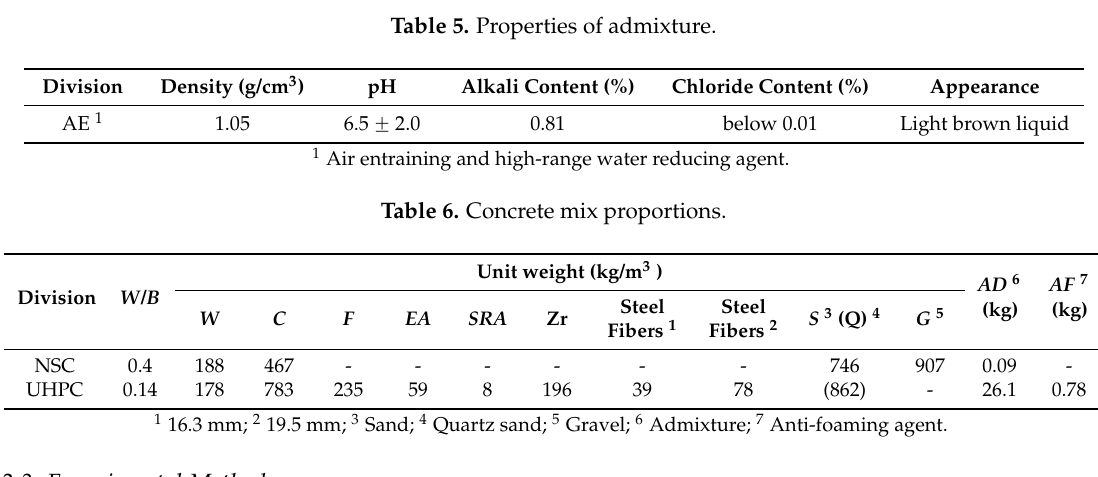
Table 4. Physical properties of aggregates.